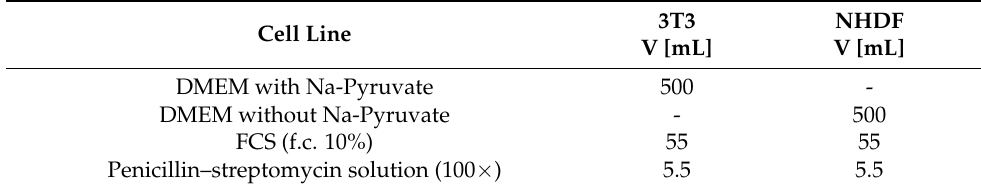
Table 2. The compositions of the cell media.